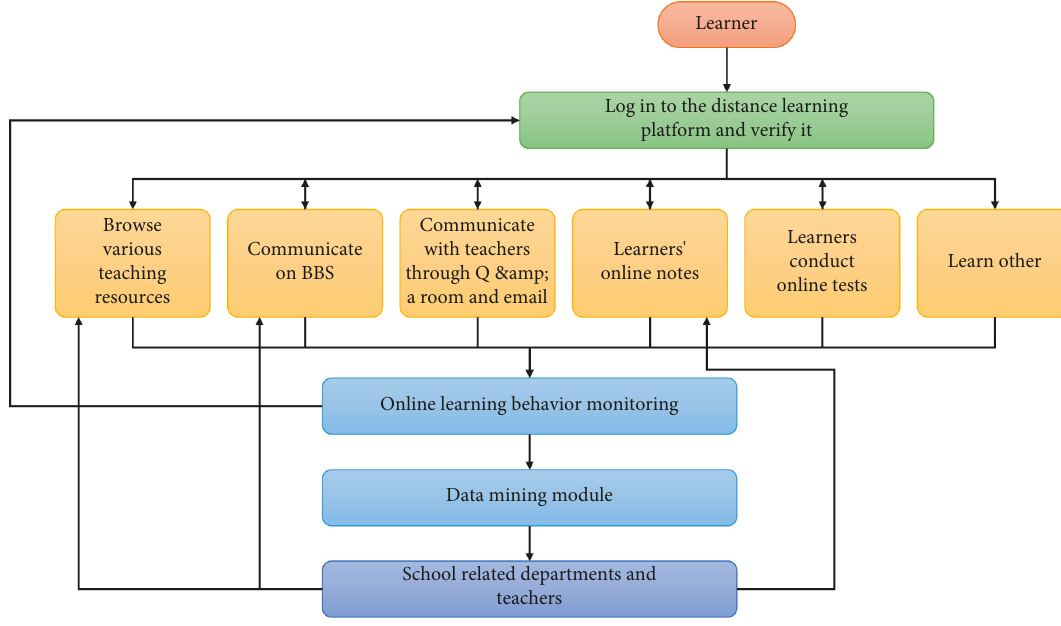
Figure 6: Network autonomous learning system